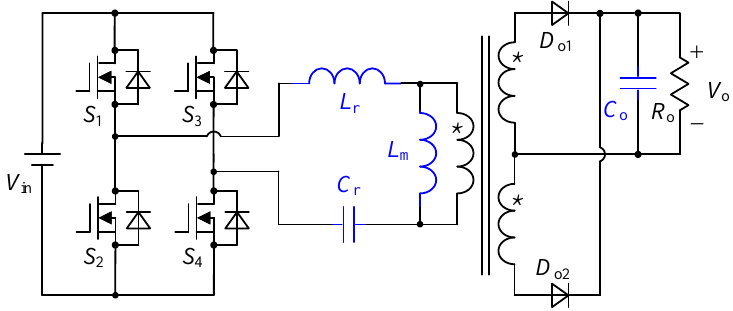
Figure 1. The circuit of LLC resonant converter in the ideal case.